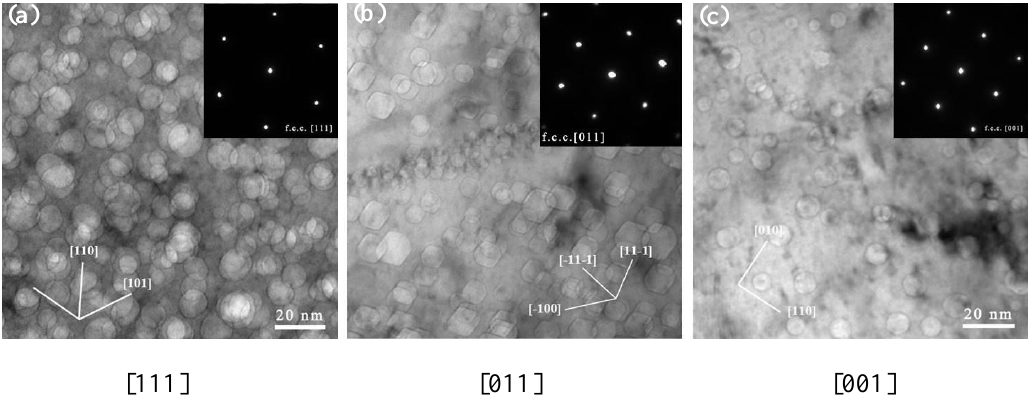
Figure 6. Comparison of the experimental observations of helium bubbles with the projected shape of an octahedron for the different zone axes: ( a ) [111], ( b ) [011], and ( c ) [001] in the fcc matrix. Based on these observations, a polyhedron composed of {111} planes is suggested to surround the bubble. Geometric construction of a polyhedron consisting of {111} planes shows an octahedral shape. In most cases, a truncated octahedron or octahedron with rounded edges and corners is more energetically favorable [27]. Since it is embedded in the substrate and consists of {111} substrate planes, the octahedron has the same symmetry as the substrate. In order to minimize the overall free energy, it is expected that the facets with the lowest surface energy will occupy most of the surface. In the fcc structure, the lowest surface energy is found on the most closely packed {111} planes. In our case, {100} planes occupy the corners of the octahedral composed of {111} planes, which means that there is a {111} octahedron with six {100} truncations. The total surface area of a faceted bubble with the {111} surface decreases when the bubble is truncated by the {100} planes. A truncated octahedron or rounded corners are more energetically favorable.